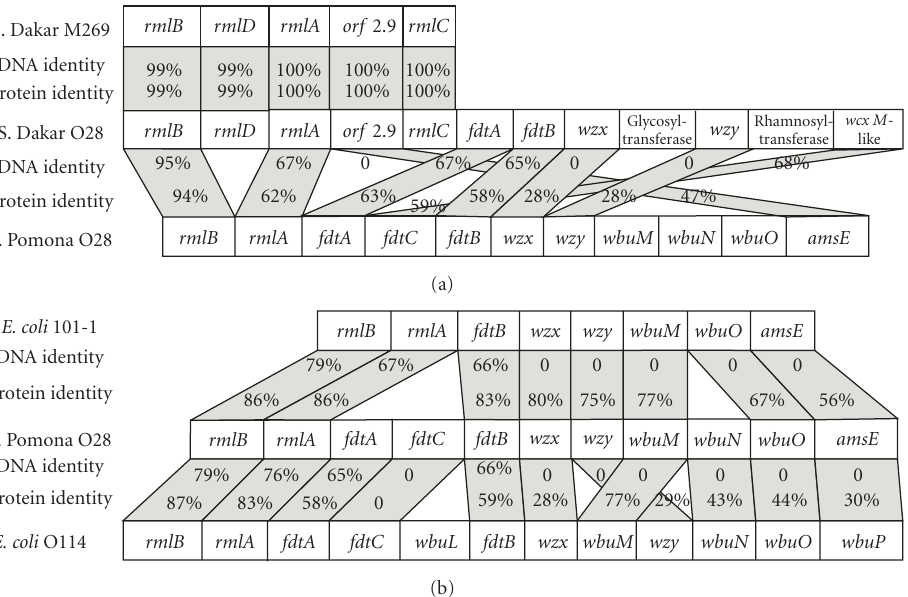
Figure 1: Comparison of O antigen regions: A. S. Dakar O28 versus S. Pomona O28 and S. enterica serotype Dakar M269; B. E. coli 101-1 versus S. Pomona O28 and E. coli O114. The S . Pomona and S . Dakar O-antigen cluster DNA sequences were deposited with GenBank (accession numbers EU805803 and FJ467642, resp.). The E. coli O114 O antigen cluster was accession number AY573377, while E. coli 101-1 O antigen cluster sequence data was from E. coli 101-1 gcontig 1112603666495, accession number NZ